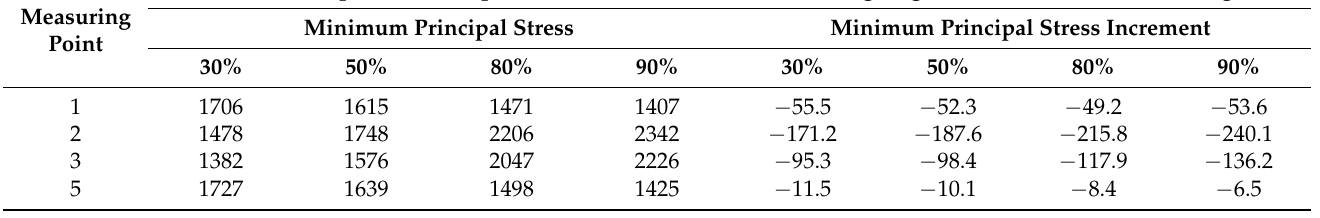
Table 13. Maximum principal stress amplitude of measuring points 1, 2, 3, and 5 under different softening degrees of basement surrounding rock.